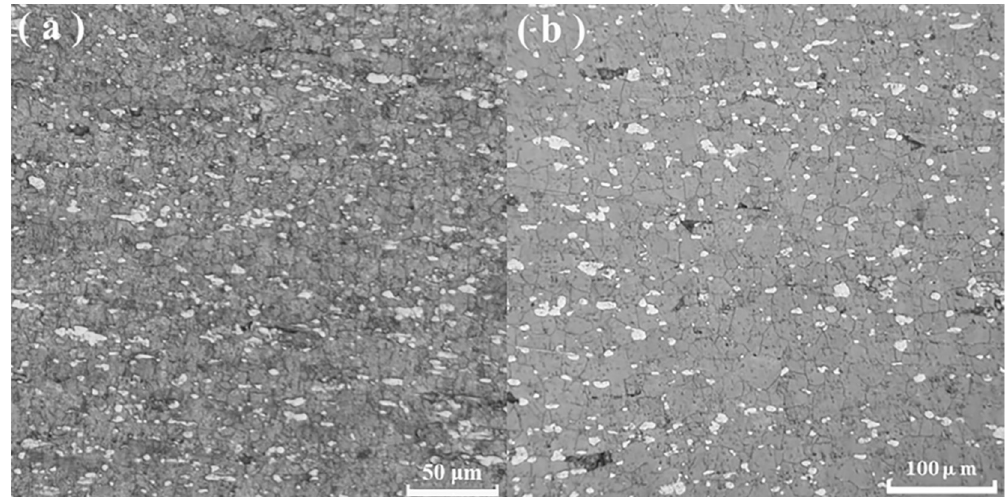
Figure 4. Microstructures of the gauge section in this alloy at ( a ) 523 K and 1 × 10 − 2 s − 1 and ( b ) 573 K and 5 × 10 − 4 s − 1 .